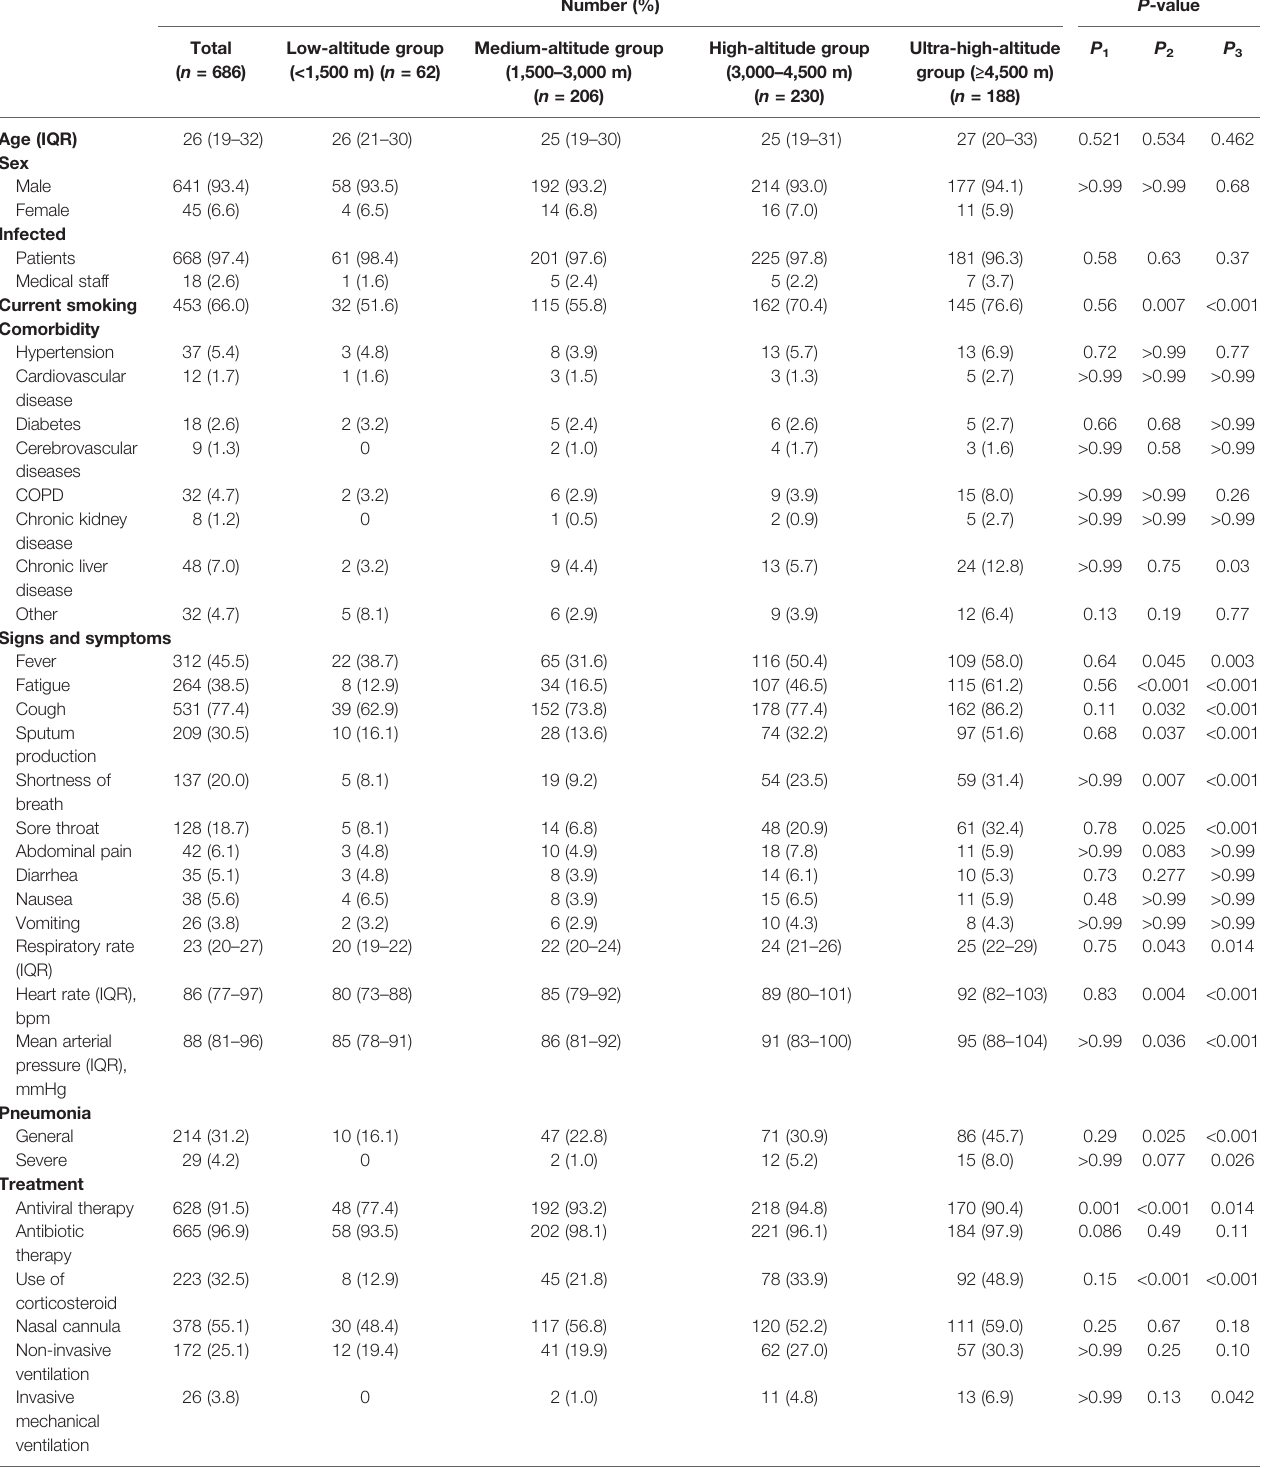
TABLE 1 | Demographics and clinical characteristics of study